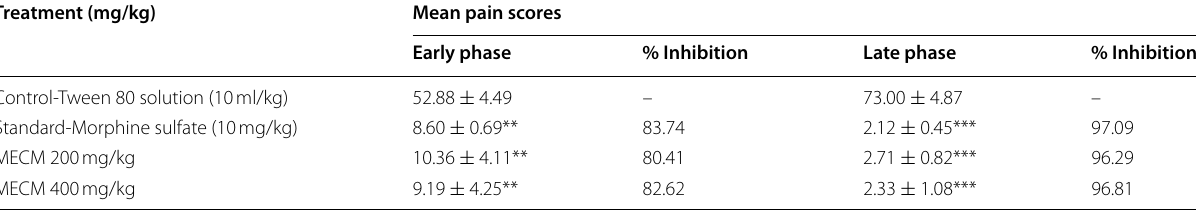
MECM Methanolic extract of seeds, SEM Standard error of the mean All values are expressed as Mean SEM ( N 5) ± = ** p < 0.01, *** p < 0.001 were considered statistically significant compared to control Table 6 Effect of MECM on formalin-induced paw edema inhibition